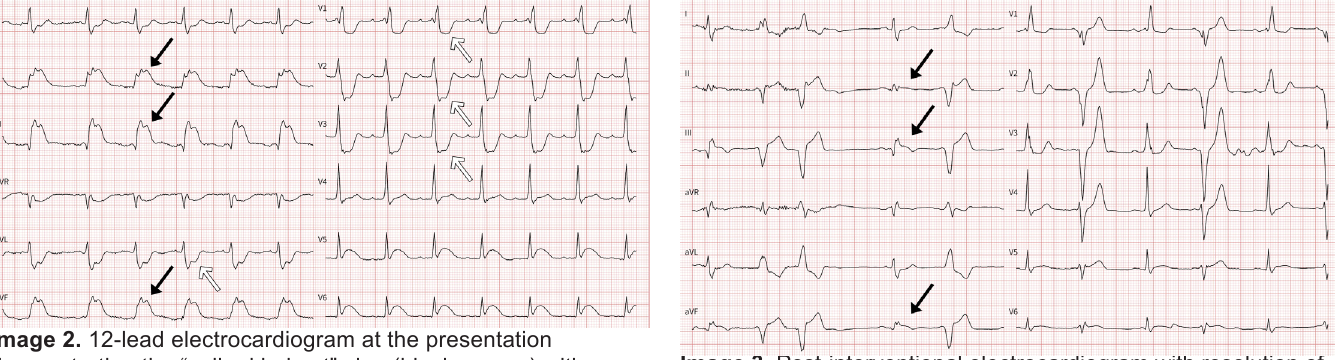
Image 3. Post-interventional electrocardiogram with resolution of the “spiked helmet” sign